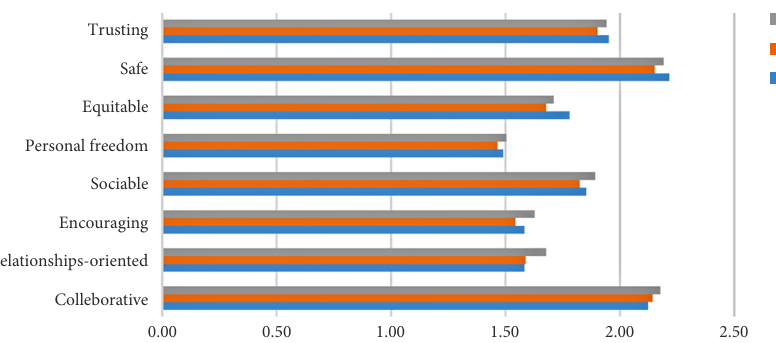
Figure 3. Supporting culture characteristics according to Wallach (1983) (source: Prepared by the